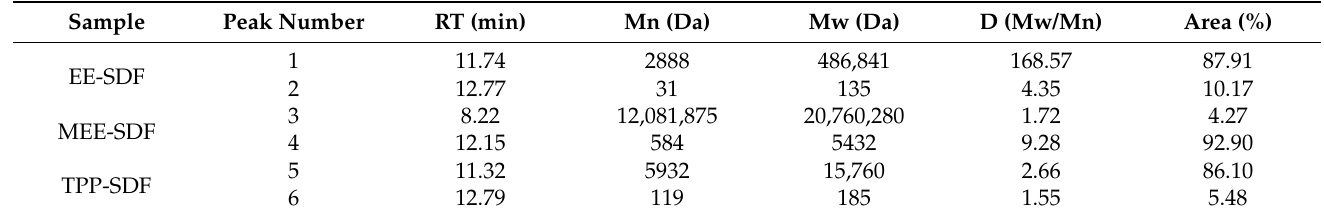
Table 3. Molecular weights and polydispersity (Mw, Mn, and Mw/Mn) of SDFs.